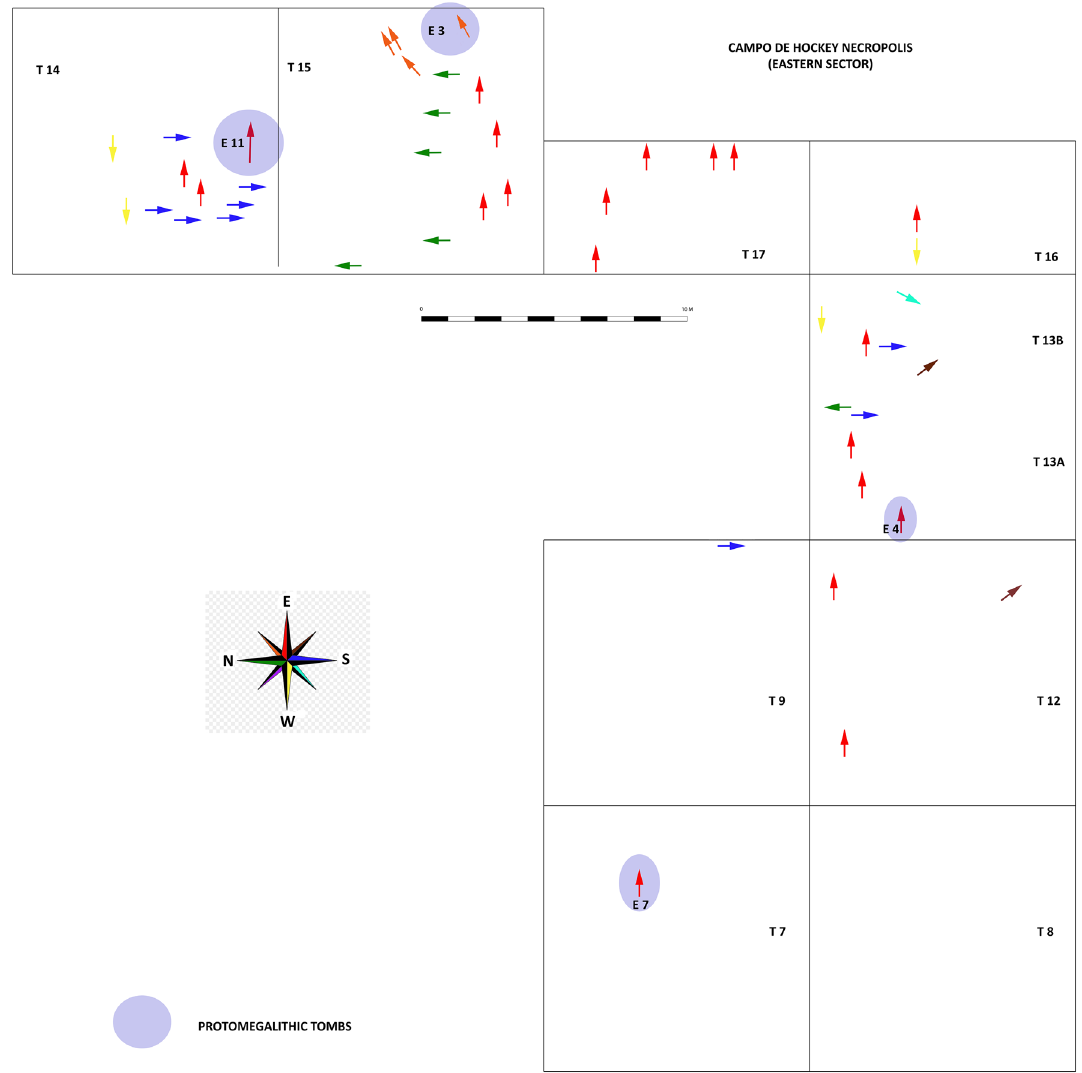
Figure 7. Plan of the Campo de Hockey necropolis, with indication of orientation of the individuals (the arrowhead would indicate the position of the head). Photo montage was designed with the application of Adobe Photoshop version CC 2021 (22.3.1) (http:// www. adobe.